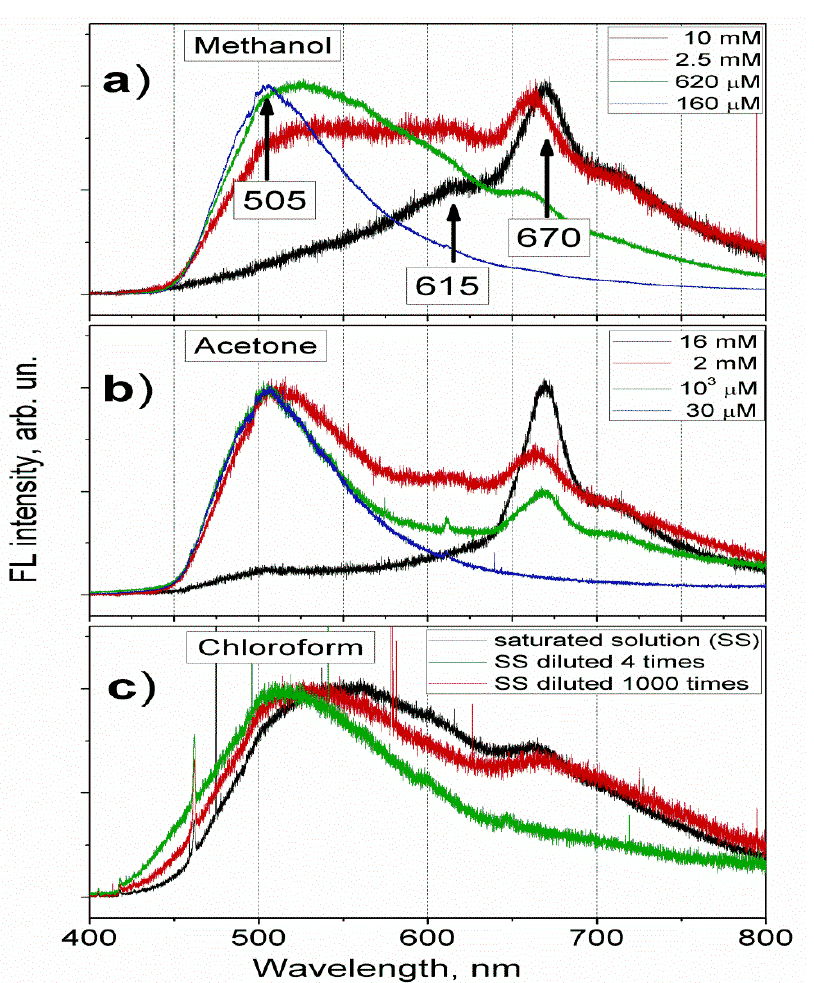
Figure 1. FL emission spectra measured at room temperature on Q solutions in: ( a ) methanol, ( b ) acetone, and ( c ) chloroform, with different concentrations. To facilitate comparison, all the spectra were normalized to one by dividing each spectrum by its highest value.